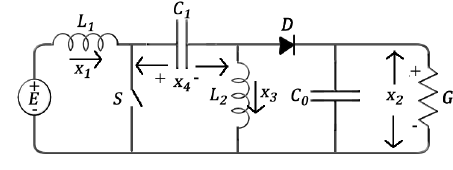
Figure A1. SEPIC converter.